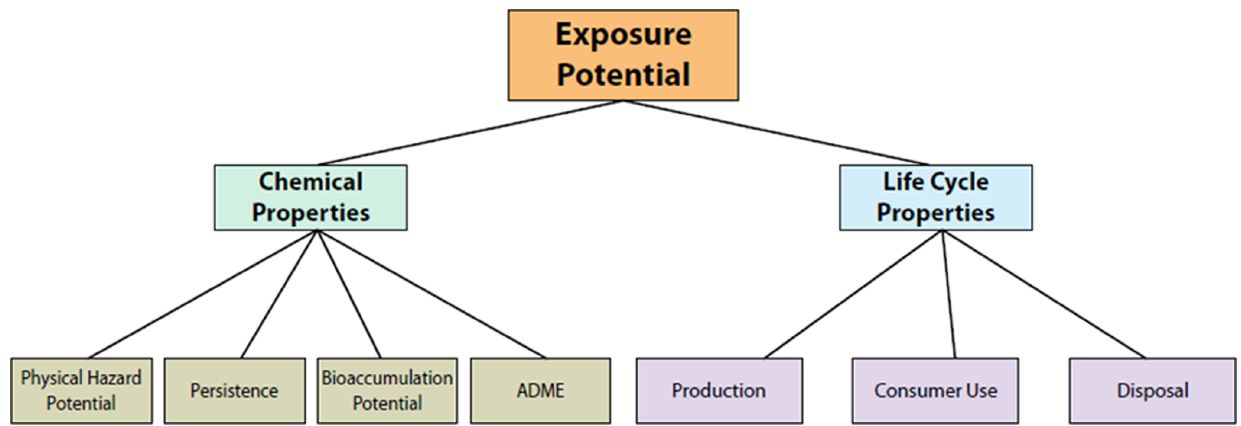
Figure 1. MCDA Framework for Exposure-Based Chemical Prioritization.